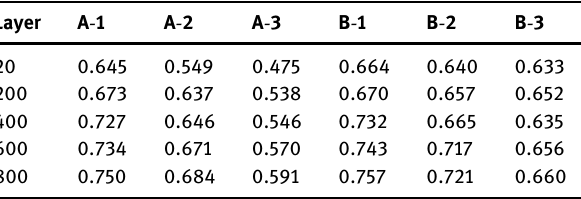
Table 2: Statistical table of de - lamination damage variables of rock samples Layer